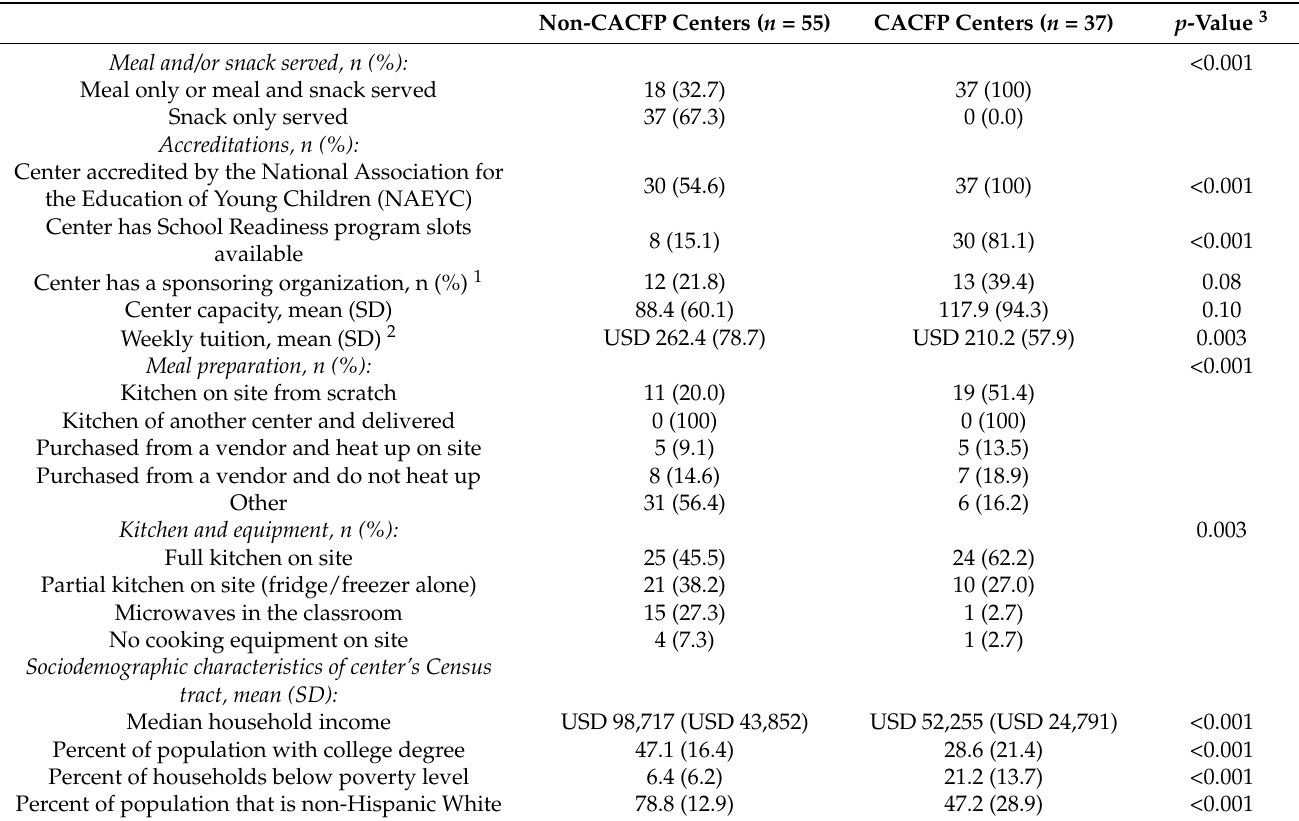
Table 1. Demographics characteristics of n = 92 Connecticut-licensed child care centers in 2019 1 .